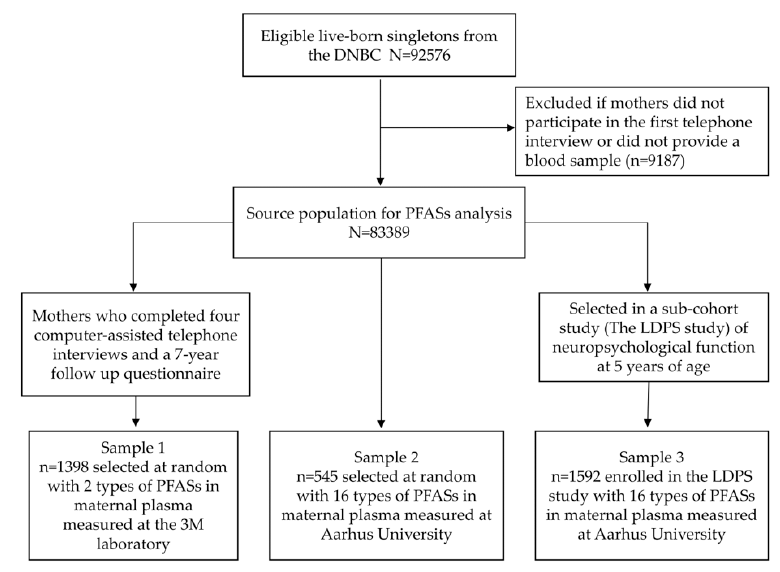
Figure 1. Selection of three DNBC sub-samples.